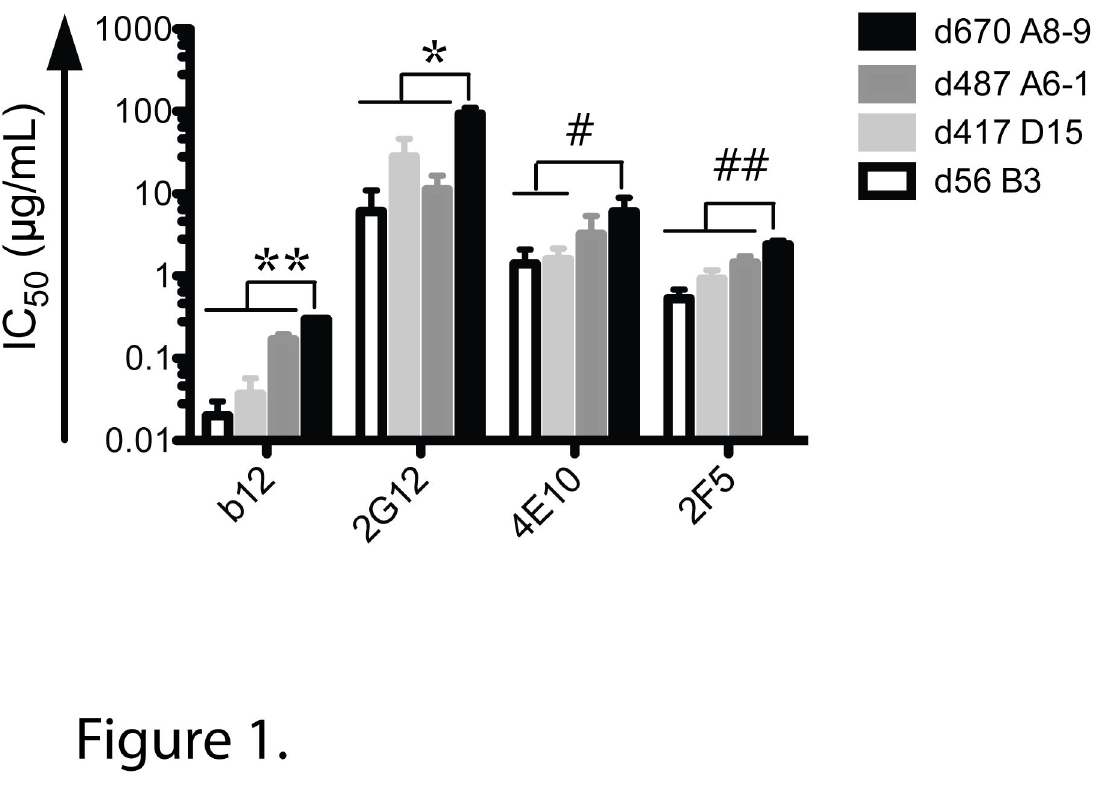
Figure 1. Early A141 variants are more sensitive to monoclonal antibodies than late variants. Serially diluted MAbs (b12, 2G12, 4E10 and 2F5) were tested for the neutralization of the pseudovirus of interest (d56 B3, d417 D15, d487 A6-1 and d670 A8-9) in a TZM-bl cell assay. The MAb concentration (µg/mL) required to reach 50% neutralization of each pseudovirus is reported as IC (µg/mL). Data shown are mean +/- SD from three independent assays. Compared to d670 A8-9: * P < 0.005, ** P < 0.0005, # 50 P < 0.02, # # P <